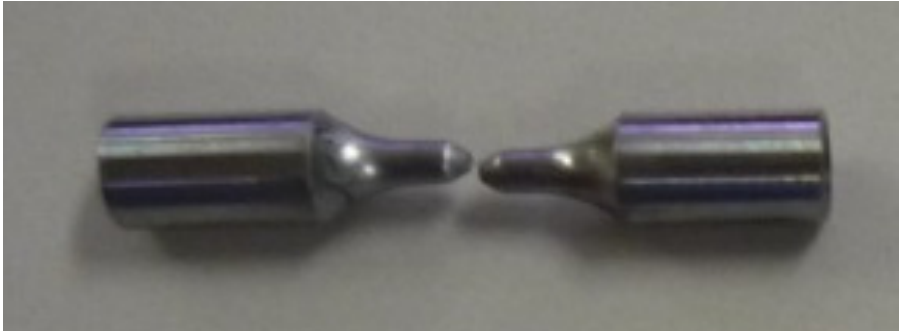
Figure 3. Small round-bar specimen for tensile tests. Dimensions are in mm.